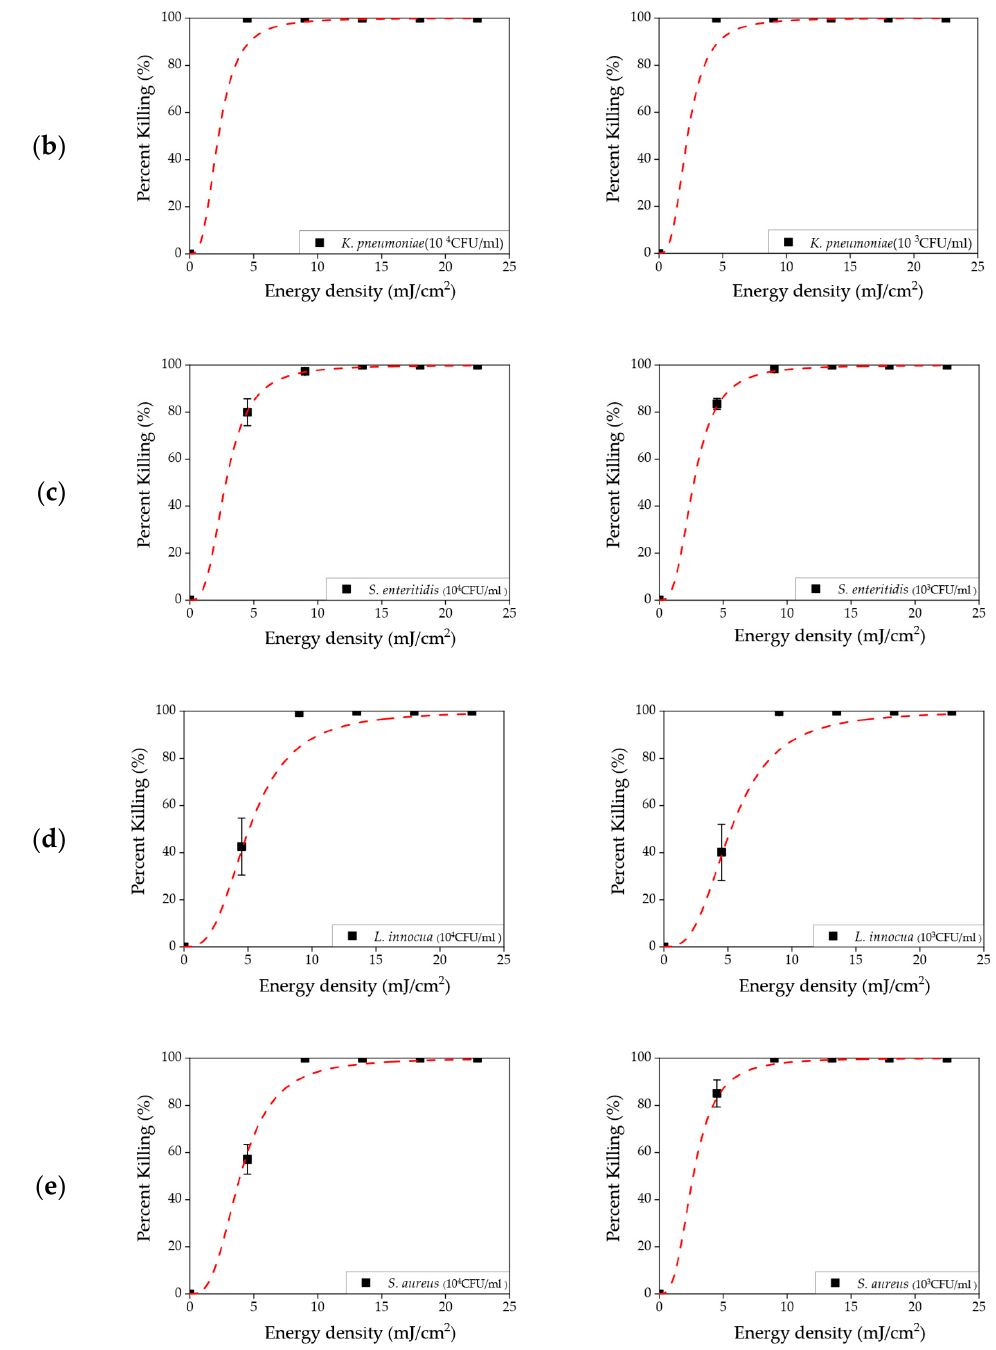
Figure 4. Killing rate as a function of energy density in a liquid sample for ( a ) E. coli , ( b ) K. pneumoniae , ( c ) S. enteritidis , ( d ) L. innocua , and ( e ) S. aureus . The left and right concentrations are 10 4 and 10 3 CFU/mL, respectively.